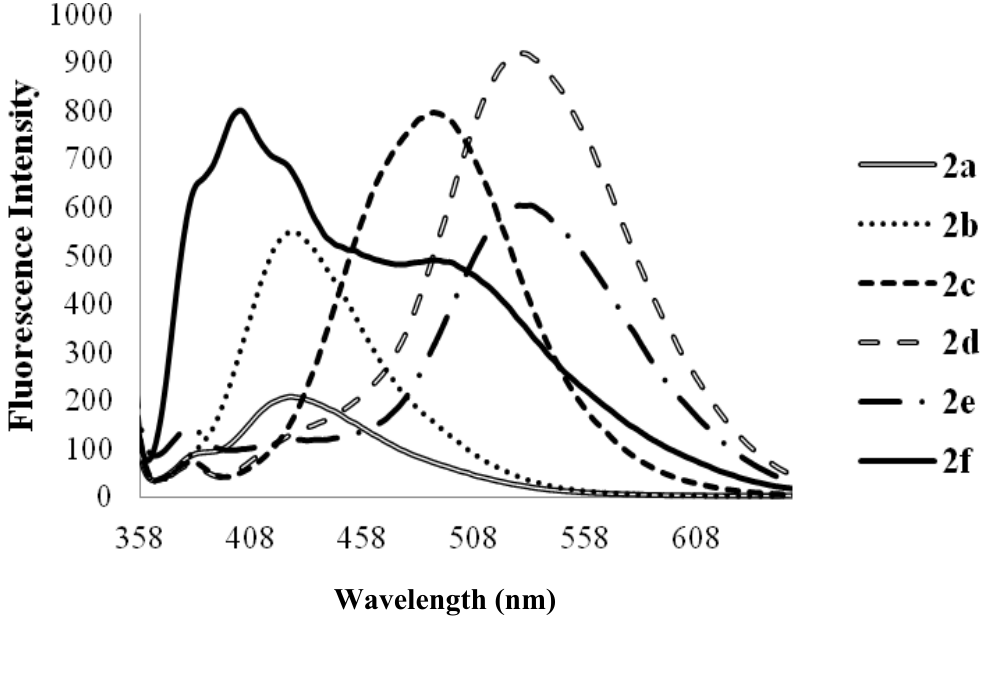
Figure 7. The fluorescence emission spectra of 2a – f ( λ conc. (2.0 × 10 − 7 mol/L) at rt.